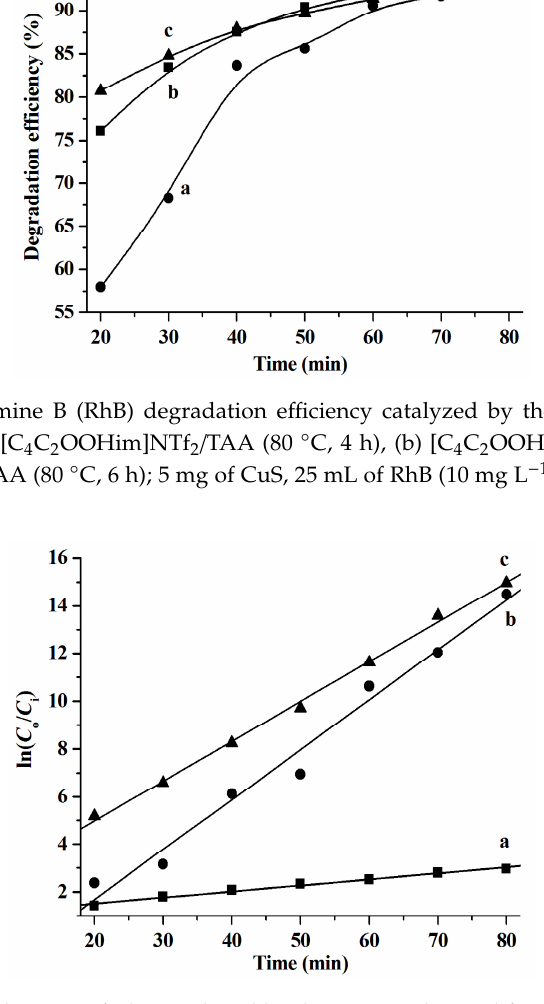
Figure 7. Degradation kinetics of RhB catalyzed by the CuS synthesized from different systems. (a) [C 4 C 2 OOHim]NTf 2 /Na 2 S, (b) [C 4 C 2 OOHim]NTf 2 /TAA (80 °C, 4 h), and (c) [C 4 C 2 OOHim]NTf 2 /TAA (80 °C, 6 h); 5 mg of CuS, 25 mL of RhB (10 mg L − 1 ), and 1.0 mL of H 2 O 2 (30 wt.%).